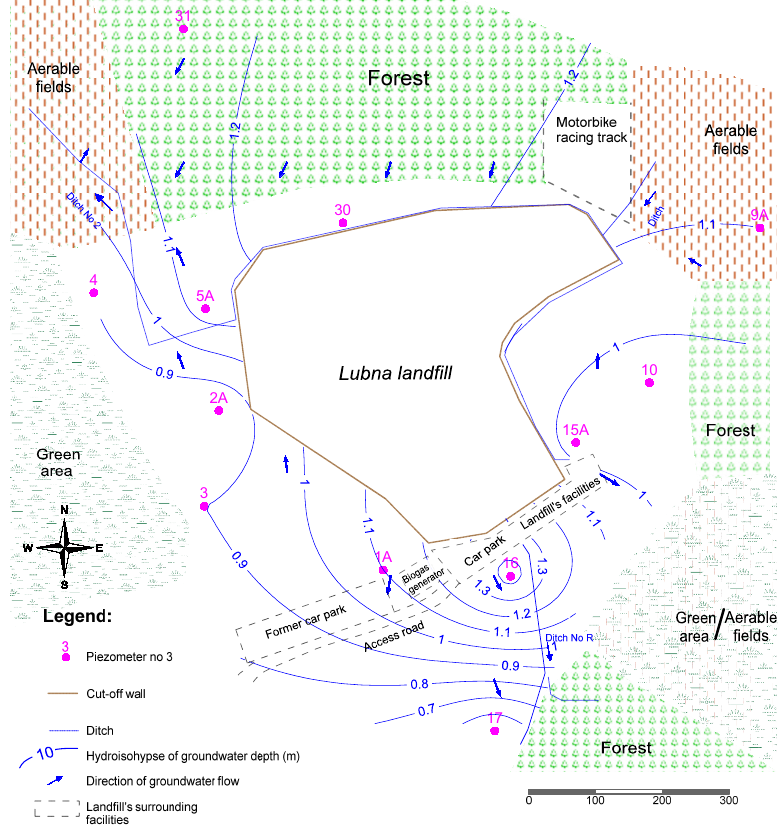
Figure 5. The groundwater depth contour map for Lubna Landfill surroundings